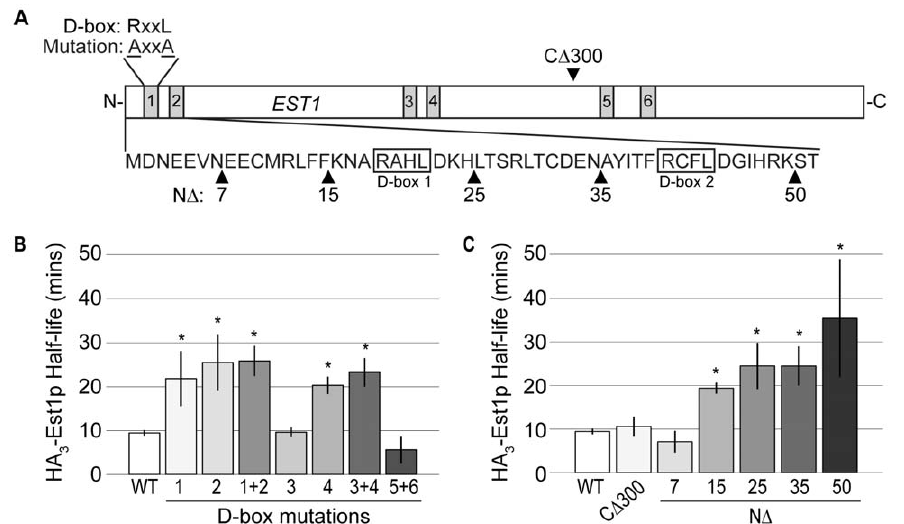
Figure 4. Est1p degradation in G1 phase requires three destruction boxes (D-boxes). (A) Schematic of EST1 shown to scale. EST1 contains six putative D-boxes with sequence RxxL (boxes labeled 1–6). Deletion of the C-terminal 300 amino acids (C D 300) results in a truncated protein that removes putative D-boxes 5 and 6. The N-terminal 52 amino acids are shown, with putative D-boxes 1 and 2 outlined. Upward pointing black triangles represent the position of the indicated N-terminal deletion. (B) D-boxes 1, 2, and 4 contribute to Est1p degradation. YKF802 containing pKF600 ( GAL1-HA 3 -EST1 ) plasmids expressing either wild-type EST1 (WT) or the D-box (DB) mutated (RxxL to AxxA) est1 alleles indicated were treated as in Figure 1B, except strains were arrested with a -factor. Bars represent the average HA 3 -Est1p half-life for three independent biological replicates; error bars are the standard deviation of the mean. Using a two-tailed t-test, there is no significant difference from WT for D-box 3 (p-value 0.833) or D- boxes 5 + 6 (p-value 0.104). D-box 1 (p-value 0.027), D-box 2 (p-value 0.012), D-boxes 1 + 2 (p-value 0.001), D-box 4 (p-value 0.001) and D-boxes 3 + 4 (p- value 0.002) are significantly different than WT, denoted by *. (C) Deletion of D-box 1 or 2 stabilizes Est1p during G1 phase. YKF802 containing pKF600 plasmids expressing either wild-type EST1 (WT) or the est1 deletion variants indicated (C D 300, N D 7, N D 15, N D 25, N D 35 or N D 50) were treated as in (A). Bars represent the average HA 3 -Est1p half-life for independent biological replicates: n=3 for each variant except N D 50, where n=4. Error bars are standard deviation from the mean; significance is denoted by *. By a two-tailed t-test, there is no significant difference between WT